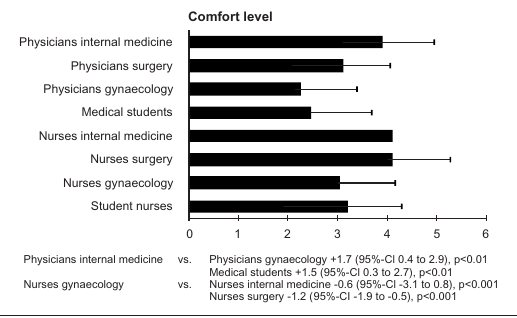
cal students the comfort level correlated reasona- bly well with the total score (r = 0.48, 95%-CI 0.29 to 0.64, p <0.001) and the subtotal score (r = 0.55, 95%-CI 0.36 to 0.70, p <0.001), whereas in nurses and student nurses the correlation was only weak (r = 0.18, 95%-CI 0.02 to 0.33, p = 0.027, and r = 0.13, 95%-CI –0.03 to 0.28, p = ns respec-